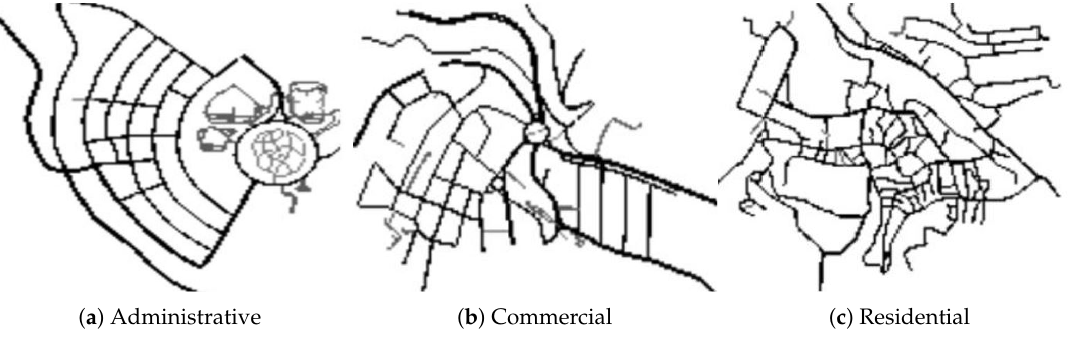
Figure 5. Area of Interest representation: SUMO